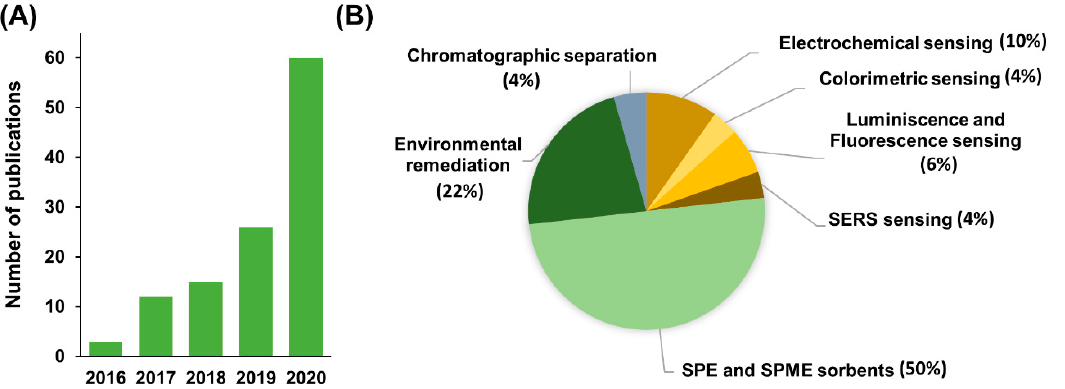
Figure 16. ( A ) Number of publications related to COF composites for analytical applications from 2016-2020 (data obtained from Scifinder ® database—August 2020), ( B ) number of publications related to COF composites divided by the analytical application.